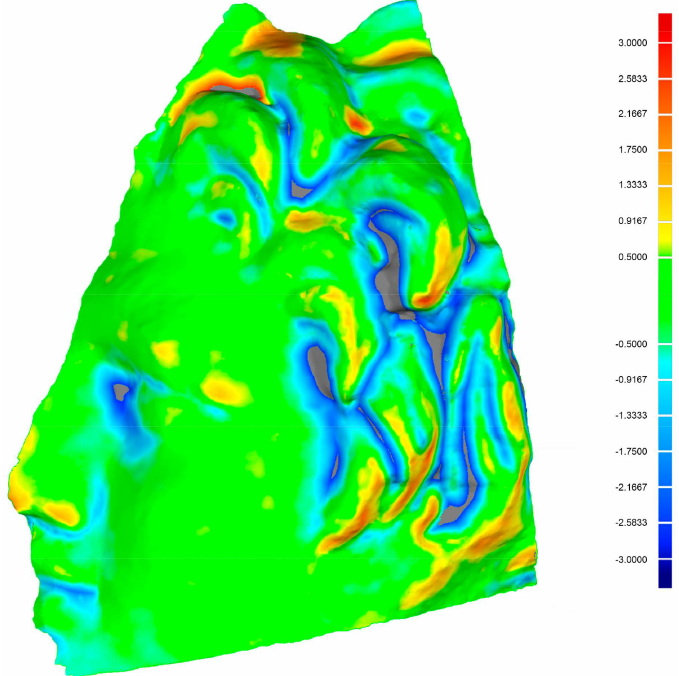
Figure 17. Comparison between the second photogrammetric model and the laser-scanning